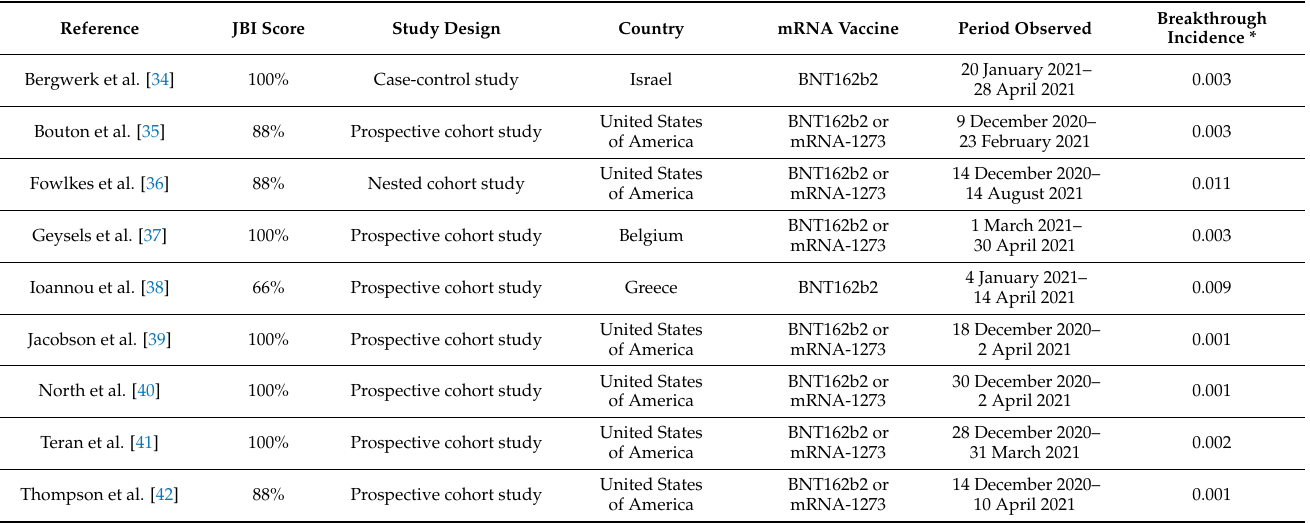
Table 1. Features of suitable